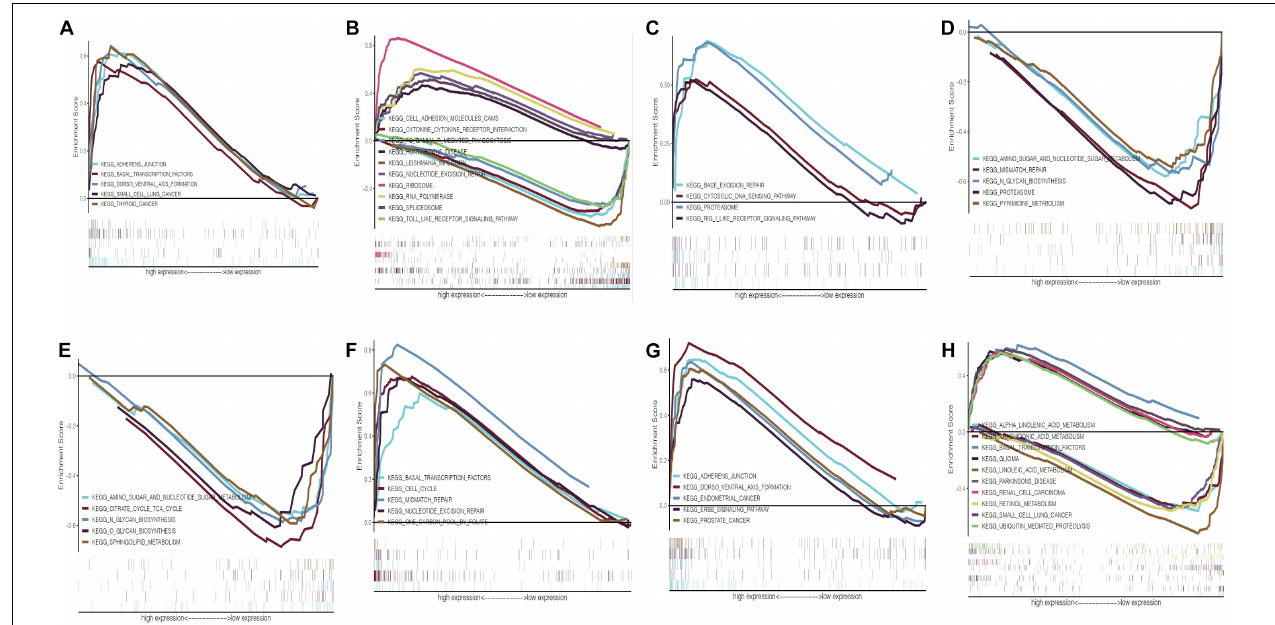
FIGURE 11 | Gene set enrichment analysis of eight modeling RBPs in PAAD. (A) PABPC1; (B) PRPF6; (C) OAS1; (D) RBM5; (E) RBM6; (F) LSM12; (G) IPO7; (H) FXR1. Only the top 5 enrichment pathways according to NES in each phenotype were displayed if available. NOM P -value < 0.05 and FDR q -value < 0.25 were considered significant. NES, normalized enrichment